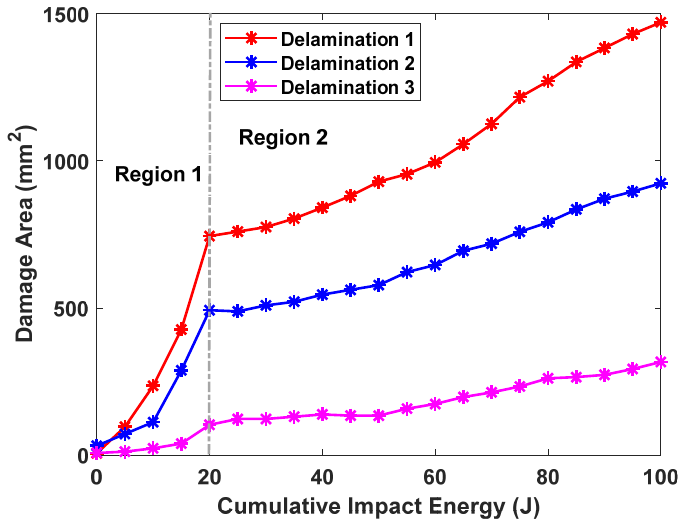
Figure 1. The damage growth area of sample S1 against the cumulative low-velocity impact ener- gies.